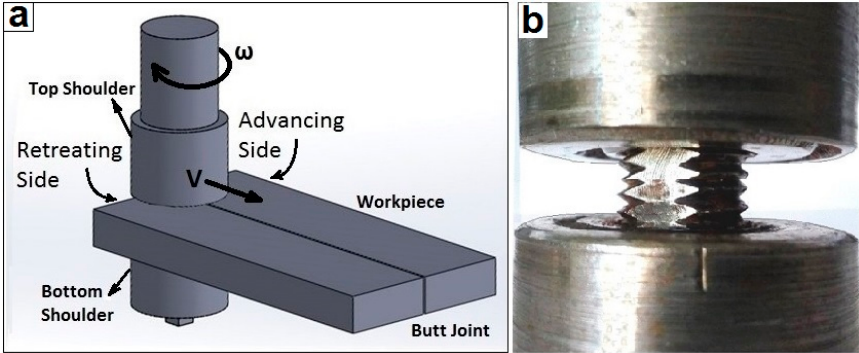
Figure 1. ( a ) Schematic of the bobbin friction stir welding (BFSW) process, ( b ) Geometric features of the bobbin tool.